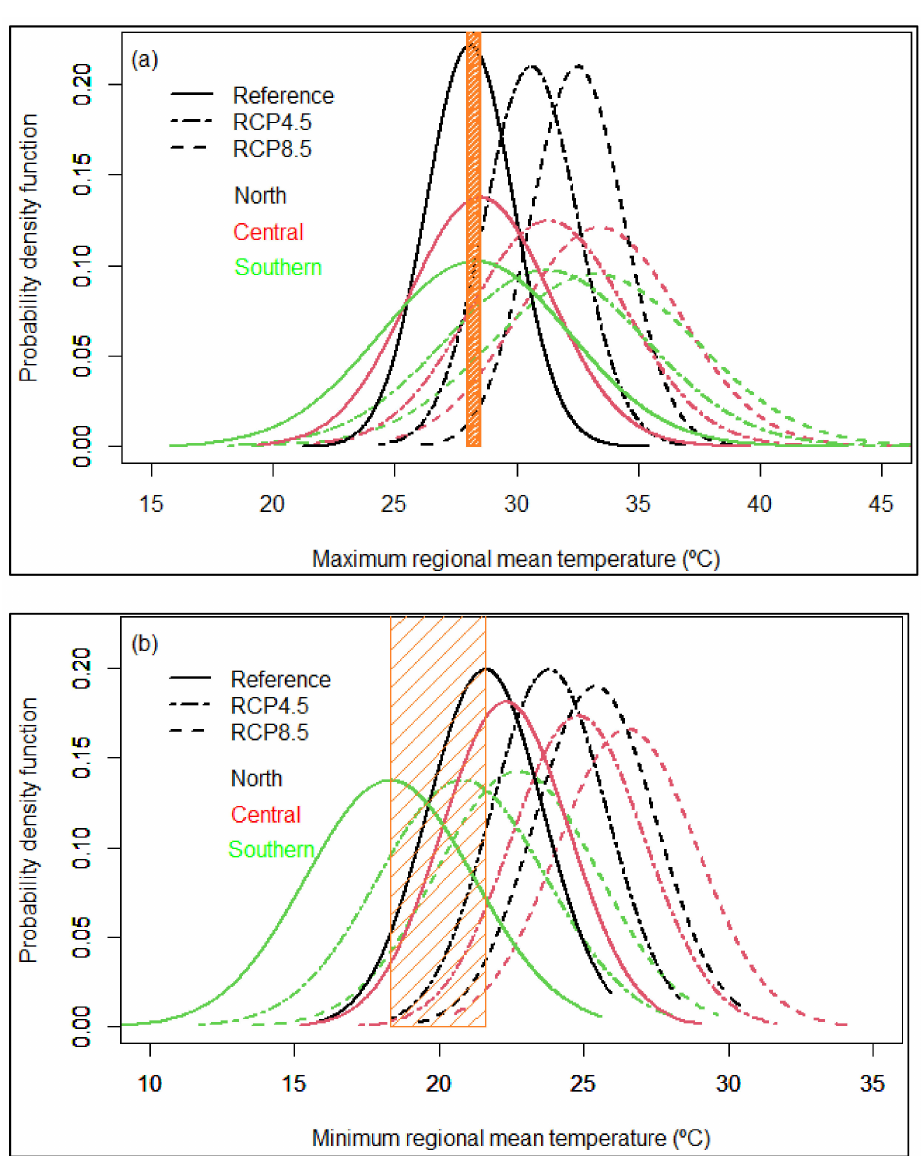
Figure 10. Probability density function of maximum ( a ) and minimal ( b ) regional mean air temper- ature distribution in the three regions (northern represented by black line, central by red line and green line for southern) over the study domain. The air temperature between shaded vertical bands represent the ranges of regional mean air temperature for reference